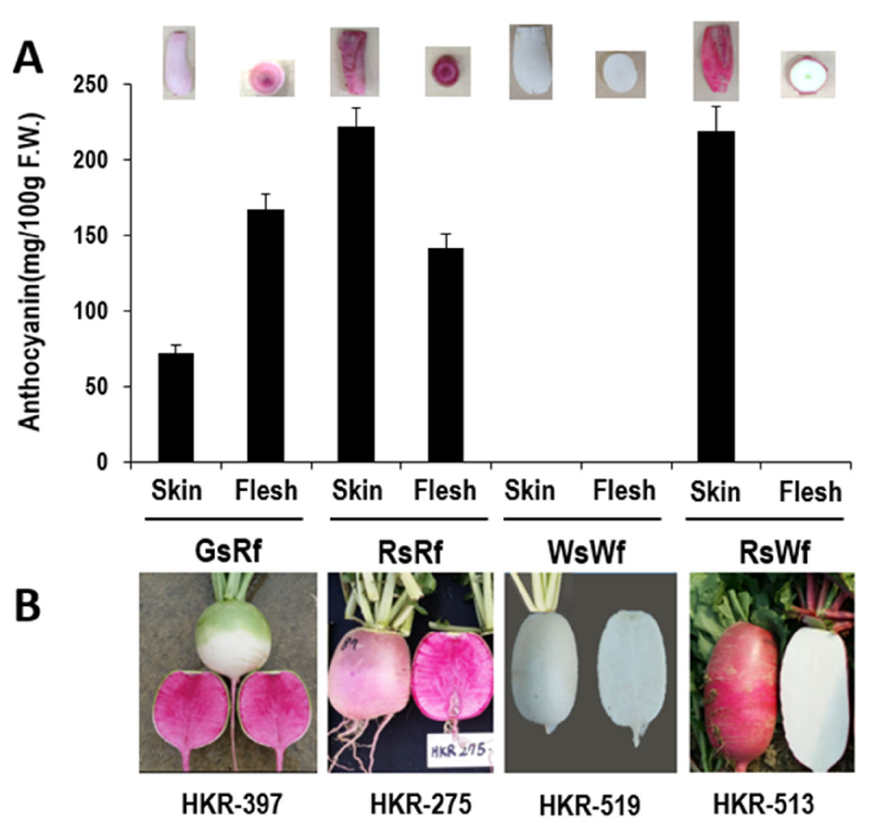
Figure 1. Four radish samples used in this study: green skin/red flesh (GsRf), red skin/red flesh (RsRf), white skin/white flesh (WsWf), and red skin/white flesh (RsWf) with inbred number (bottom). ( A ) Anthocyanin contents measured with 35 ‐ day ‐ old samples. Real photos are on top. ( B ) Photographs taken at the harvest period.